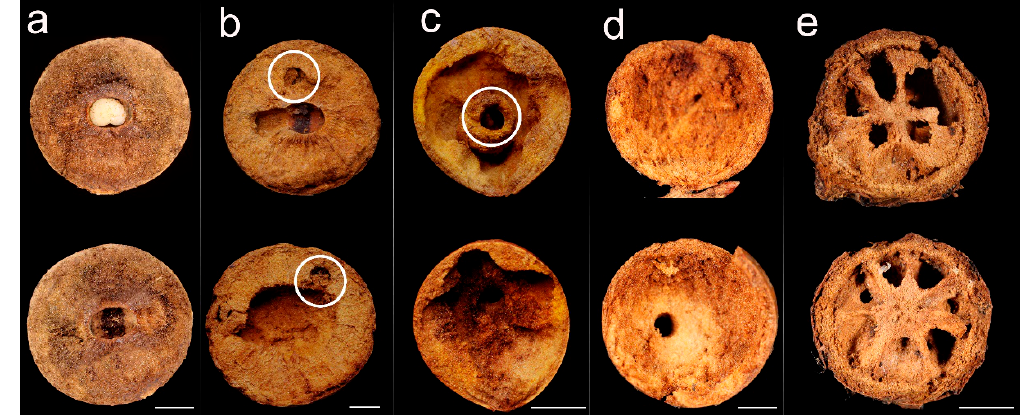
Figure 6. Inner architecture of galls colonized by C. scutellaris and C. truncata . The effect of different colony composition and the presence of aphids are shown in the two halves of the gall: ( a ) gall still occupied by the cynipid; ( b ) Qa (queen and aphids), showing evidence (circled) of the chamber where the aphids were found (1); ( c ) Qwba (queen, workers, brood and aphids), showing evidence of an aphid chamber (2); ( d ) W, the gall was completely excavated by the ants and presented a main central chamber only; ( e ) gall colonized by a single C. truncata queen. Scale bars: 5 mm.